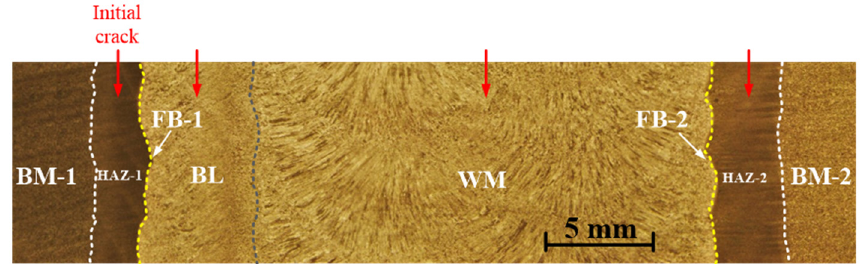
Figure 2. Macro morphology and initial crack location in DMWJ.